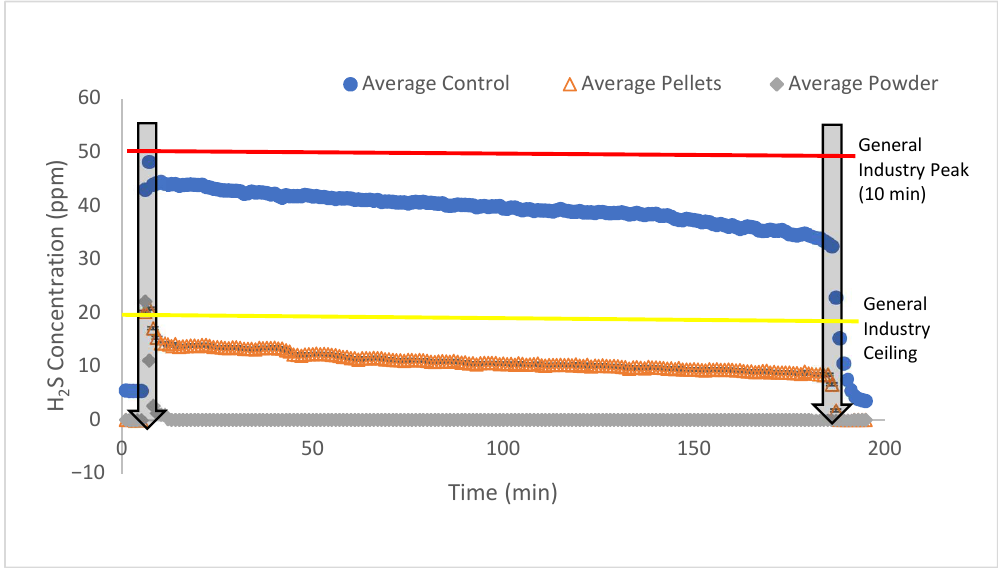
Figure 2. The average headspace concentrations of H 2 S during the 3 h agitation of swine manure treated with biochar pellets and powder. The vertical arrows indicate the start and end of manure agitation. The red and yellow lines indicate the OSHA General Industry Peak (50 ppm) and the General Industry Ceiling (20 ppm) concentrations of H 2 S.